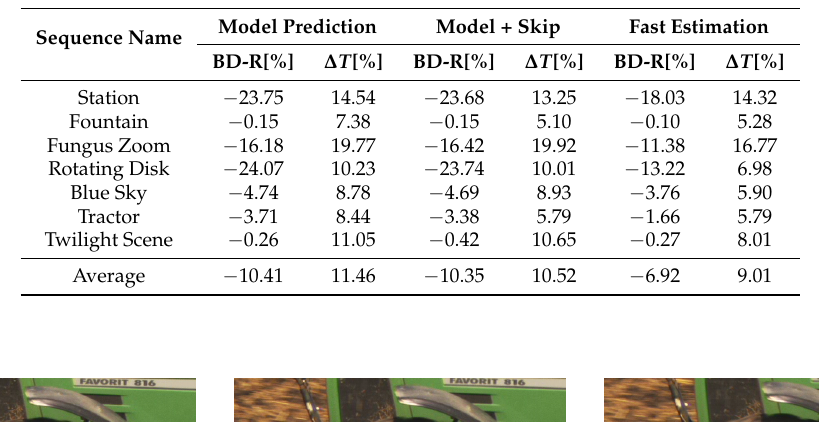
Table 4. Comparison of Coding Efficiency and Encoding Speed of the Proposed Method Variants.